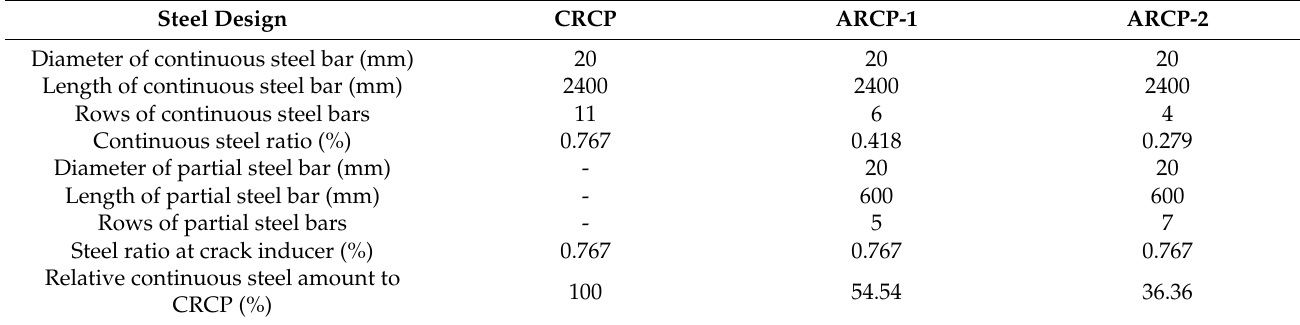
Table 5. Comparison of reinforcement layout of CRCP and advanced reinforced concrete pavement